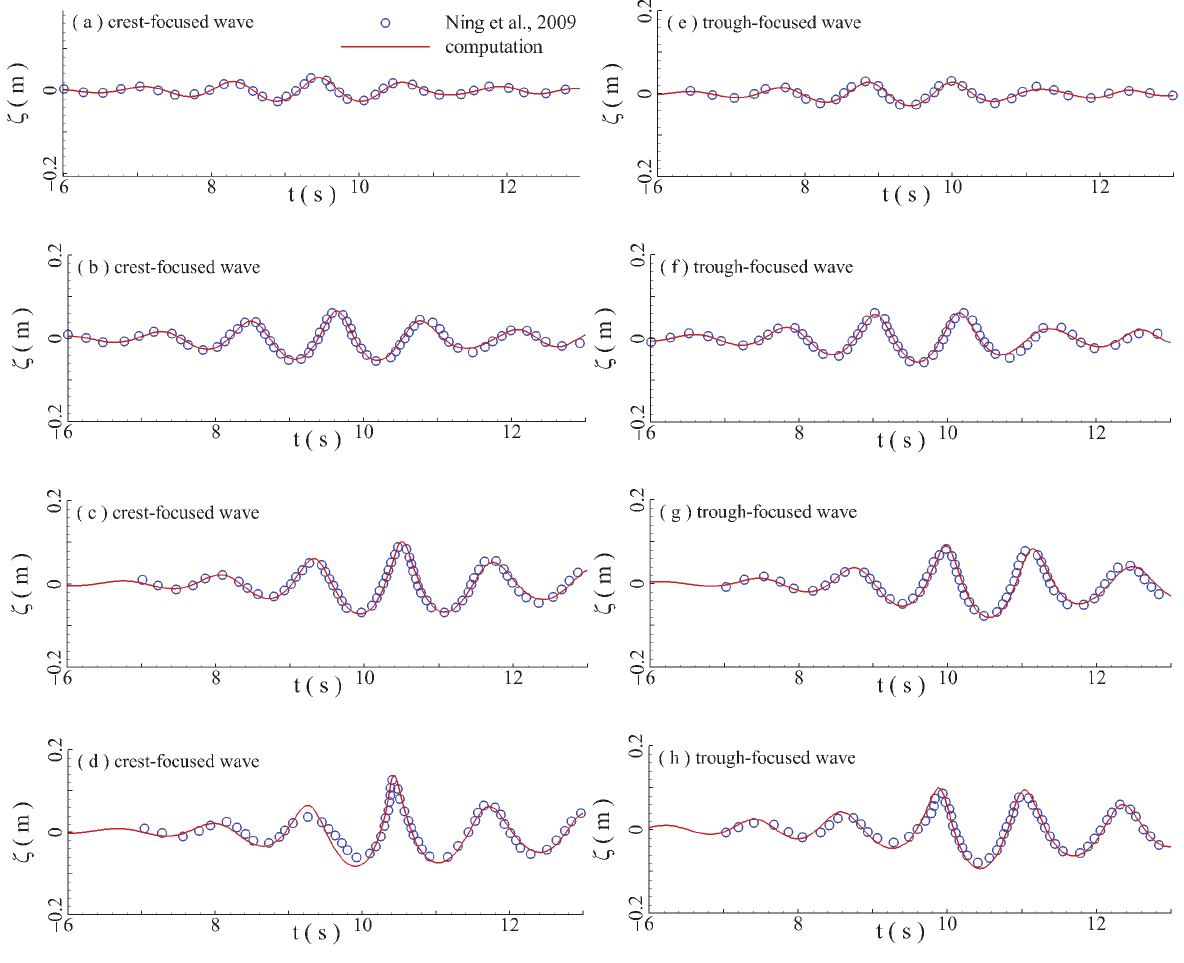
Figure 1. Comparisons of the water elevations obtained numerically with the experimental results; left side: crest-focused wave; right side: trough-focused wave; ( a , e ) Run1; ( b , f ) Run2; ( c , g ) Run3; ( d , h ) Run4.